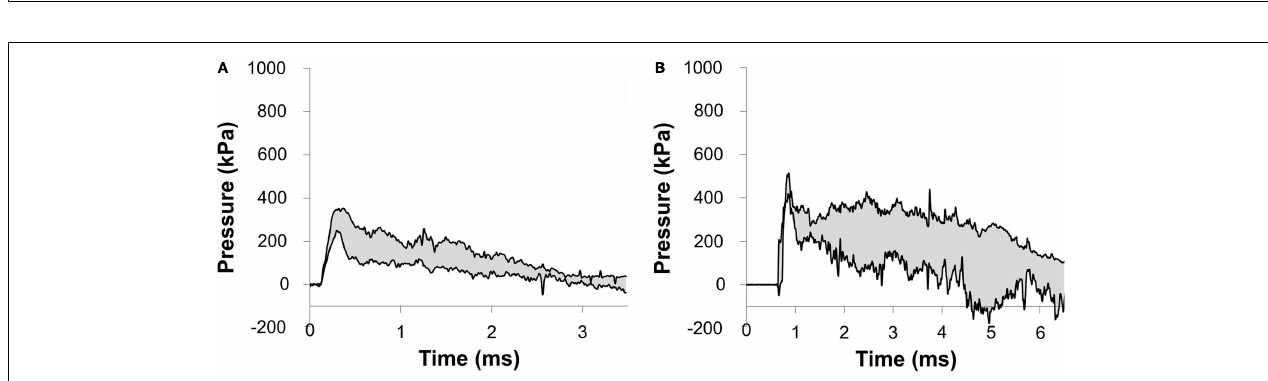
FIGURE 7 | Corridors for the pressure at the surface of the porcine head impacted with (A) a 217-kPa peak overpressure with a 2.5-ms positive phase duration and (B) a 273-kPa peak overpressure with a 6.4-ms positive phase duration incident shock wave.